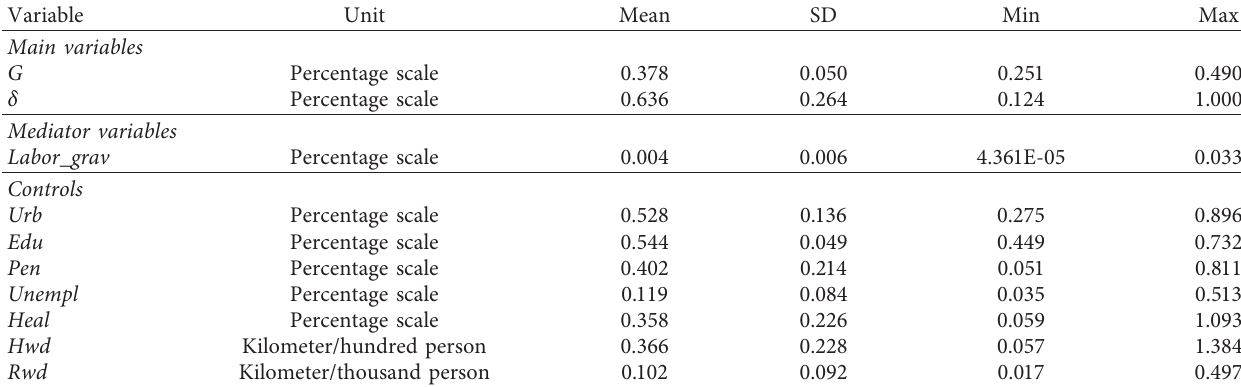
Table 1: Summary statistics for our balanced panel